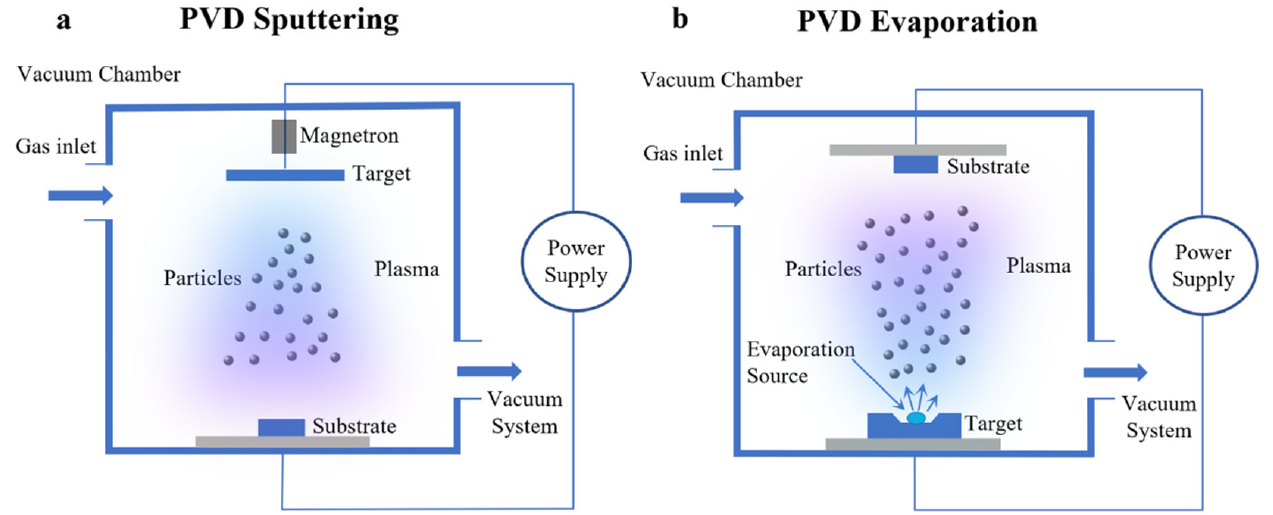
Figure 2. PVD deposition coating methods: ( a ) sputtering, ( b ) evaporation. Reprinted with permis- sion from Ref. [33]. Copyright Elsevier, 2018.